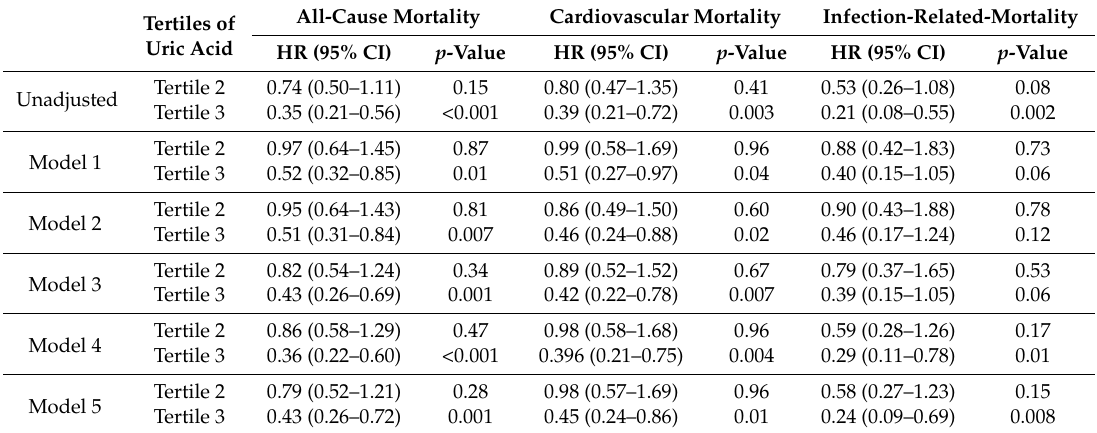
Table 3. Cox regression models of all-cause, cardiovascular, and infection associated mortality for uric acid (non-sex-specific tertiles). All-Cause Mortality Cardiovascular Mortality Infection-Related-Mortality Tertiles of Uric Acid HR (95% CI) p -Value HR (95% CI) HR (95%